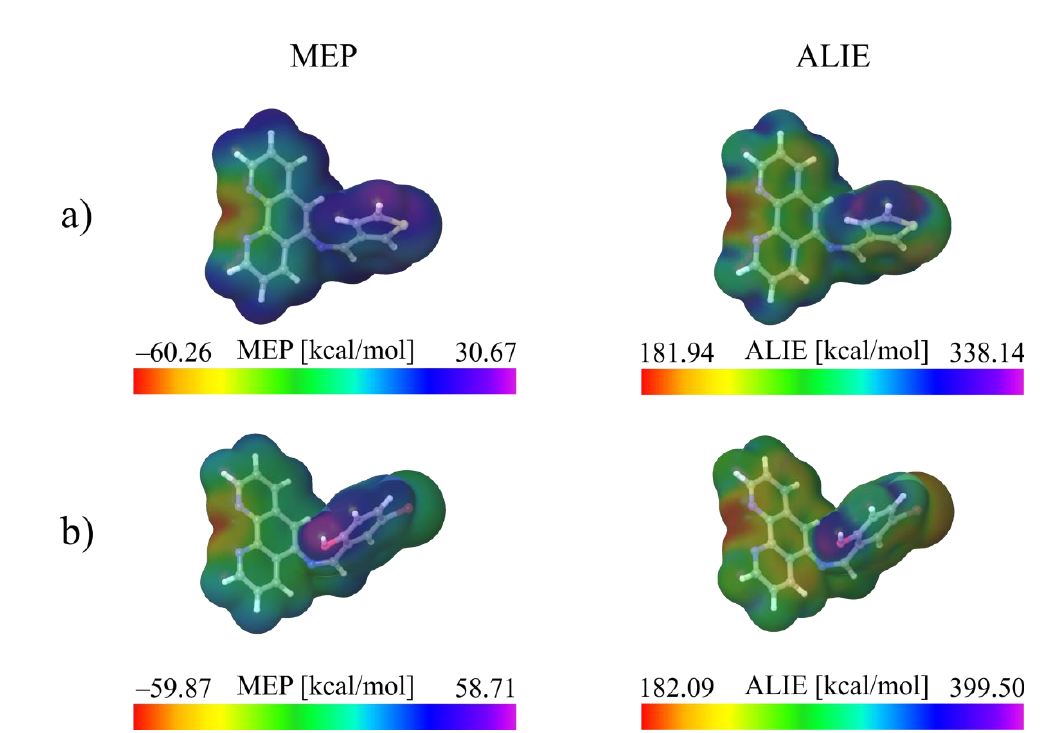
Figure 3. MEP and ALIE surfaces of ( a ) PTM and ( b ) PIB ligands.